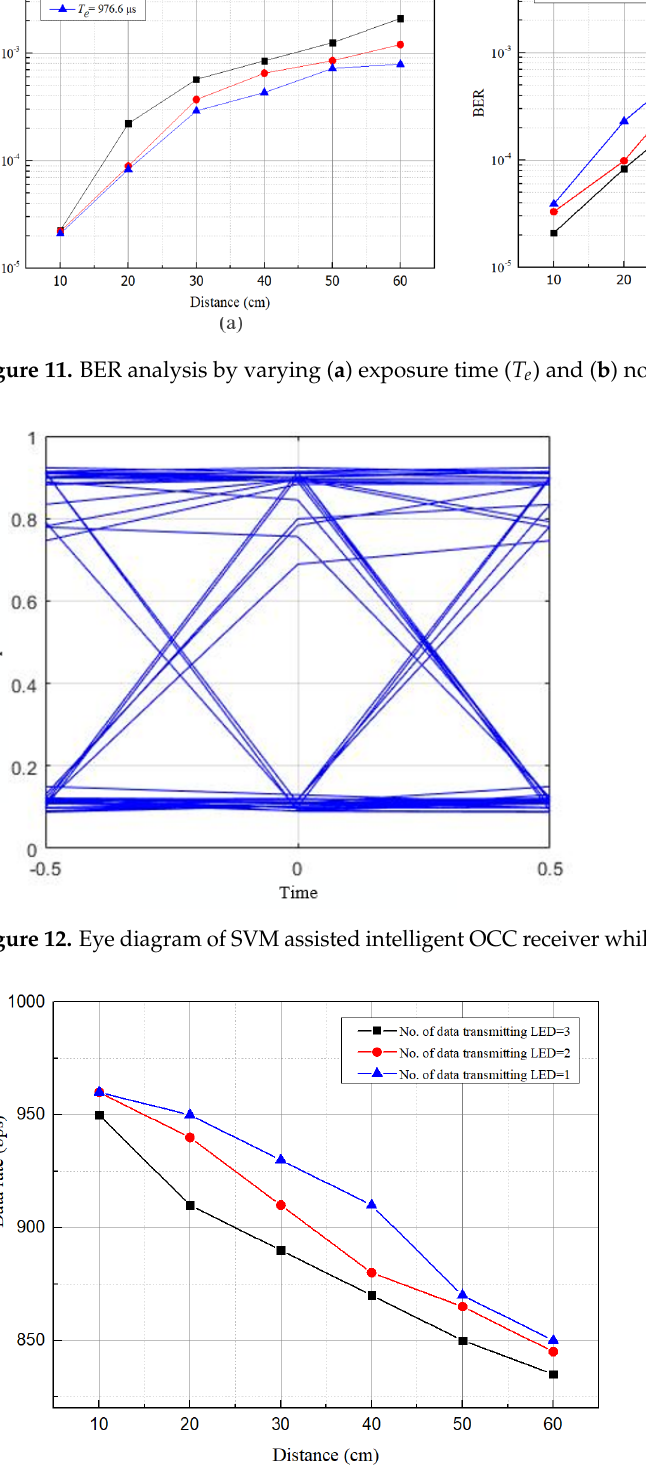
Figure 13. Data rate comparison varying no. of LEDs while T e is 977.6 µ